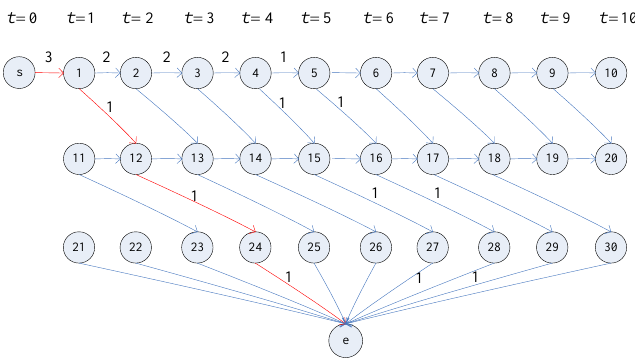
Figure 5. A nominal solution is represented in STN 1 ( V 1 , A 1 ) , where the flows influenced by resource failure is represented in the red path.